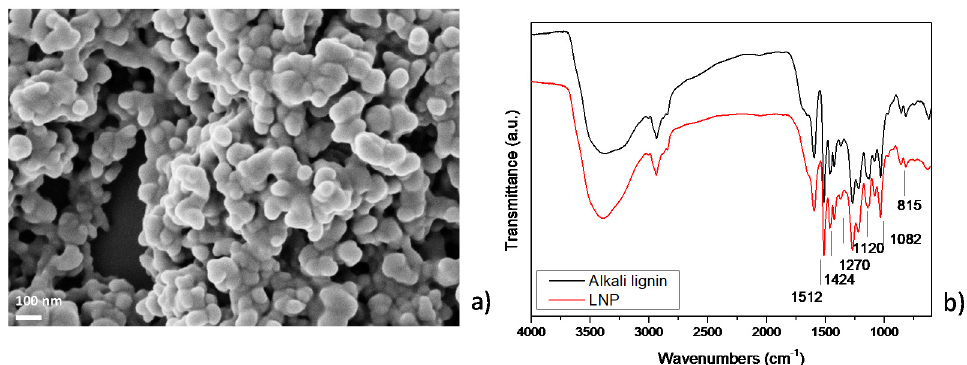
Figure 1. ( a ) FESEM image of lignin nanoparticles (LNPs) and ( b ) FT-IR spectra of micrometric lignin and LNPs in the ranges of 4000–600 cm − 1 .